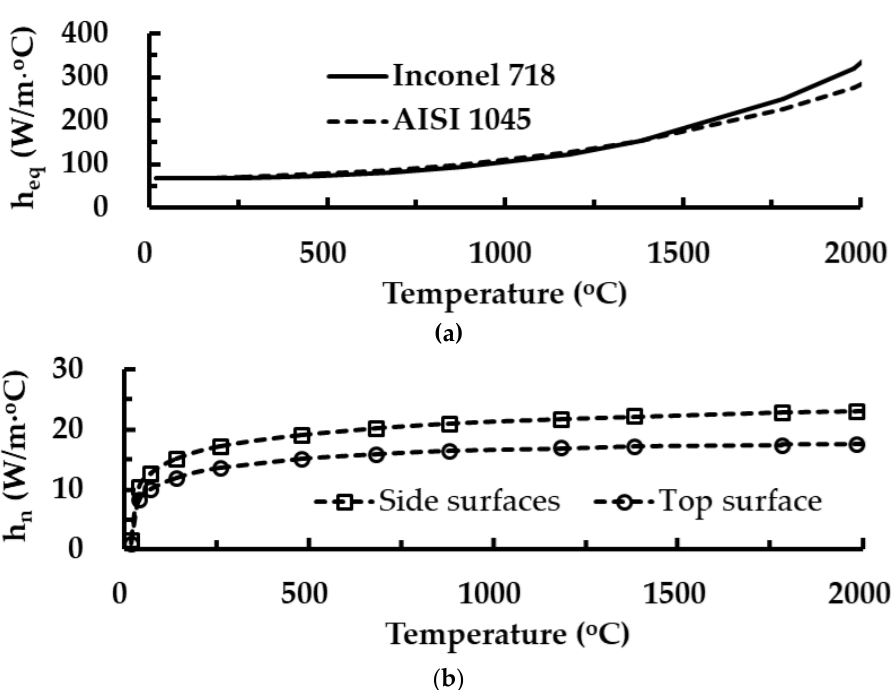
Figure 2. Coefficients of applied boundary conditions for heat transfer analyses: ( a ) temperature- dependent coefficients of the equivalent heat loss model ( h eq ); ( b ) temperature-dependent coefficients of the natural convection ( h n ).